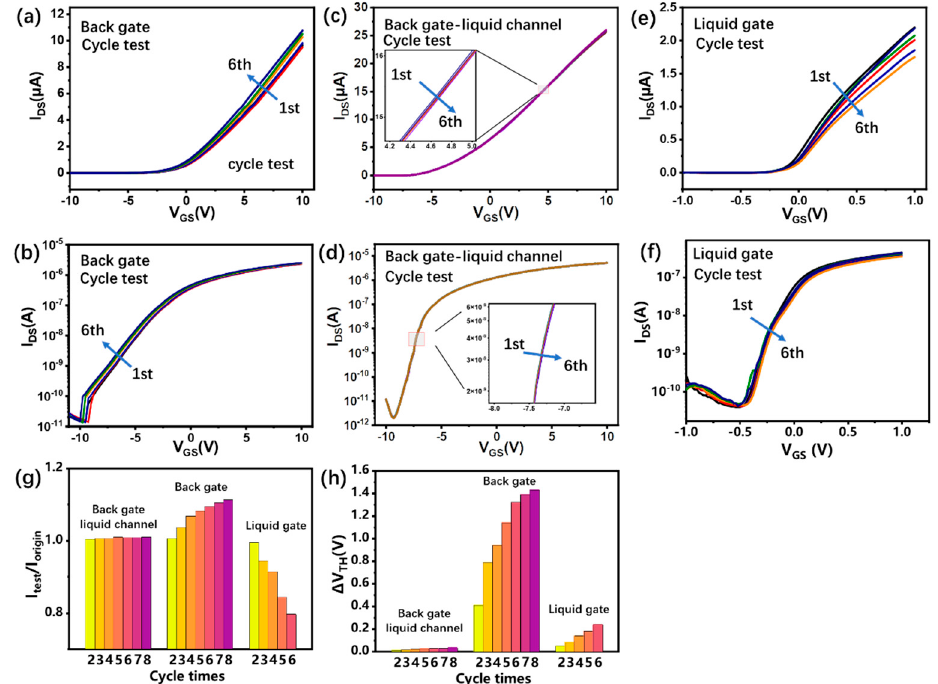
Figure 3. Results of cyclic tests in three modes. The transfer characteristics cycle tests of InSe-FET in ( a , b ) back gate dry channel, ( c , d ) back gate liquid channel, ( e , f ) and liquid gate in linear and logarithmic coordinates. The current ( g ) and threshold voltage ( h ) evolution of three modes with cycle times.Note: In back gate working mode, the point at V DS = 0.1 V, V GS = 10 V is selected to compare output current change and threshold shift; in liquid gate working mode, the point at V DS = 0.1 V, V GS = 1 V is selected to compare output current change and threshold shift.